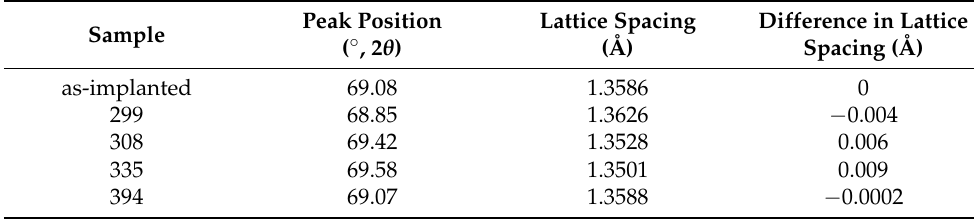
Figure 6. XRD analysis ( θ /2 θ scan). ( a ) all conditions; ( b ) as-implanted and high laser powers. Table 2. Data for the (400) XRD peak position and corresponding lattice spacing.